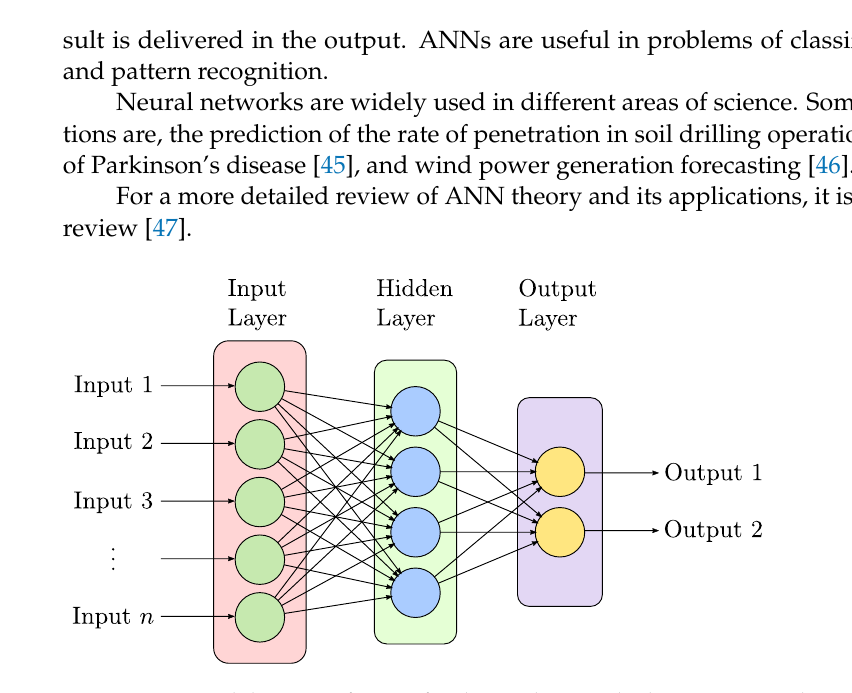
Figure 3. General diagram of an artificial neural network, the connections between layers display a feed-forward neural network